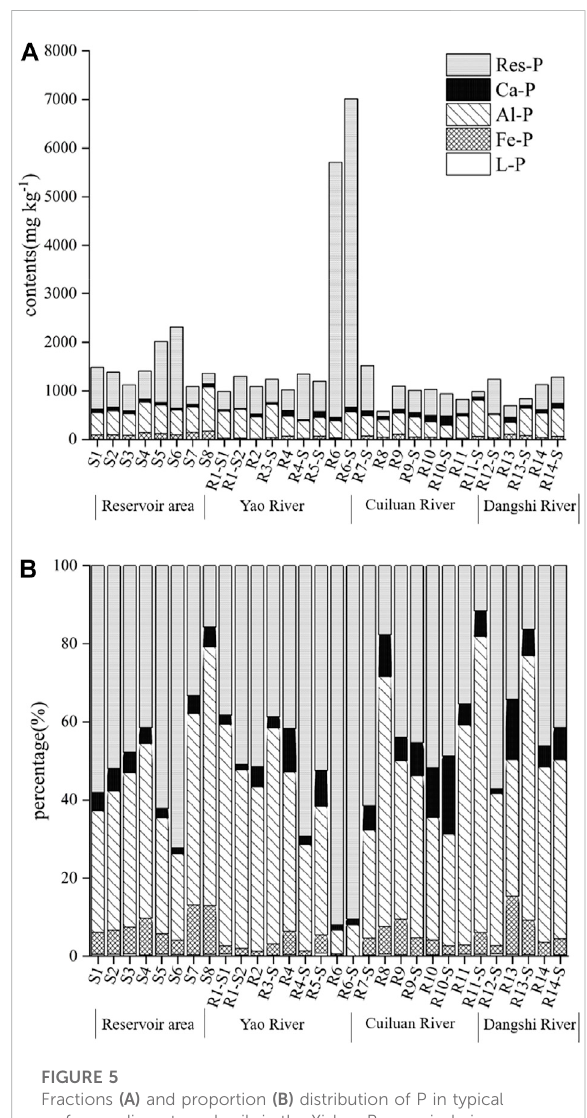
FIGURE 5 Fractions (A) and proportion (B) distribution of P in typical surface sediments and soils in the Xishan Reservoir drainage